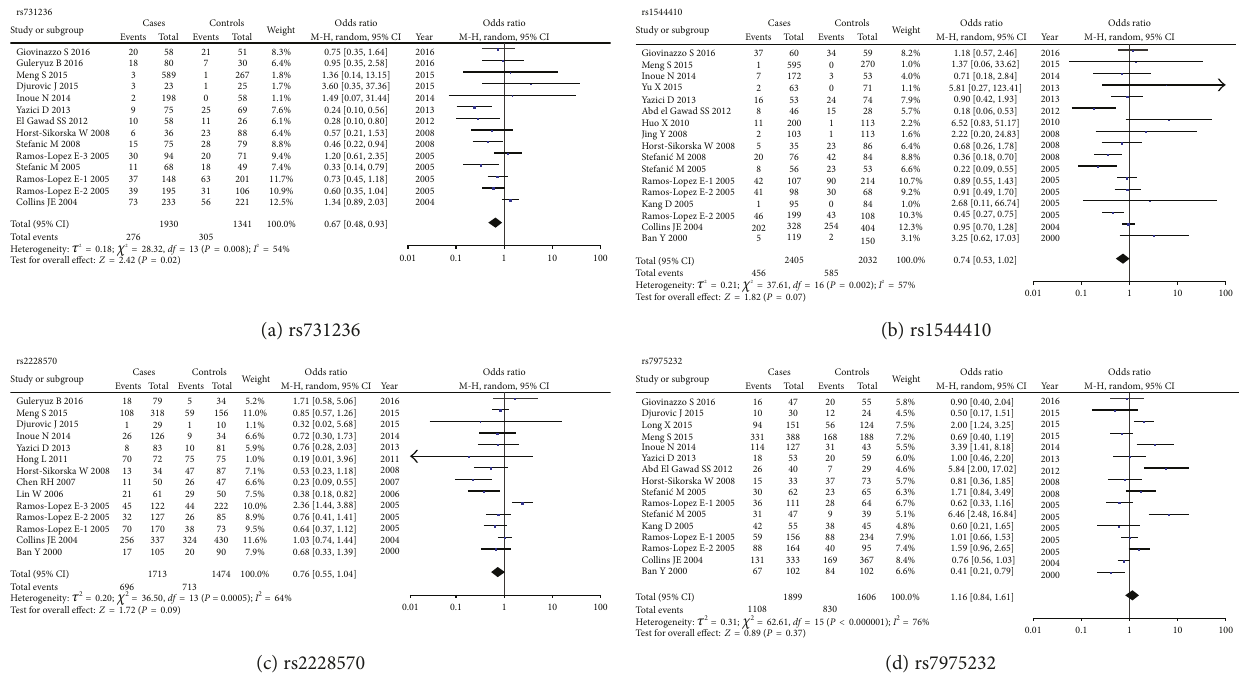
Figure 2: Forest plot of the association of VDR polymorphisms with AITD risk in homozygote comparison